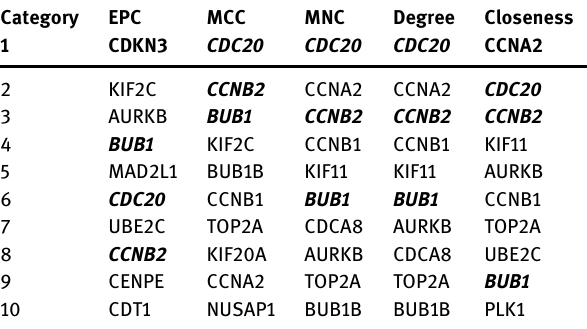
Table 2: The TOP10 genes estimated by